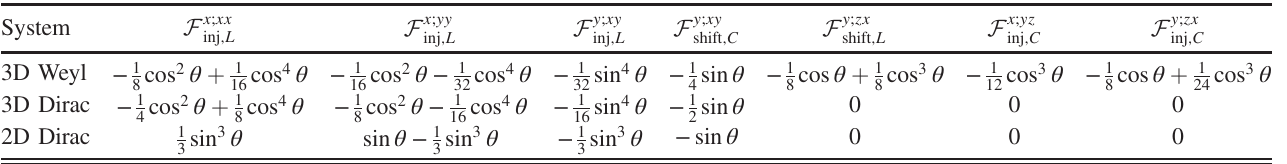
TABLE II. F c ; ab ð θ Þ of a single Weyl or Dirac point in two and three dimensions. Here, 0 ≤ θ ≤ π is the absolute value of the polar angle from the x axis. The linear shift and circular injection parts vanish for a Dirac point because of PT symmetry.